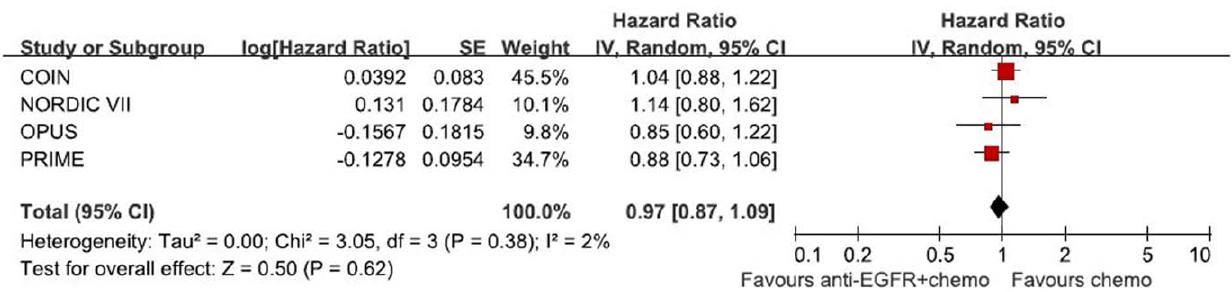
Figure 2. Randomized effect model on HR of OS. The pooled HR of OS is symbolized by a solid diamond at the bottom of the forest plot and the width of which represents the 95% CI.